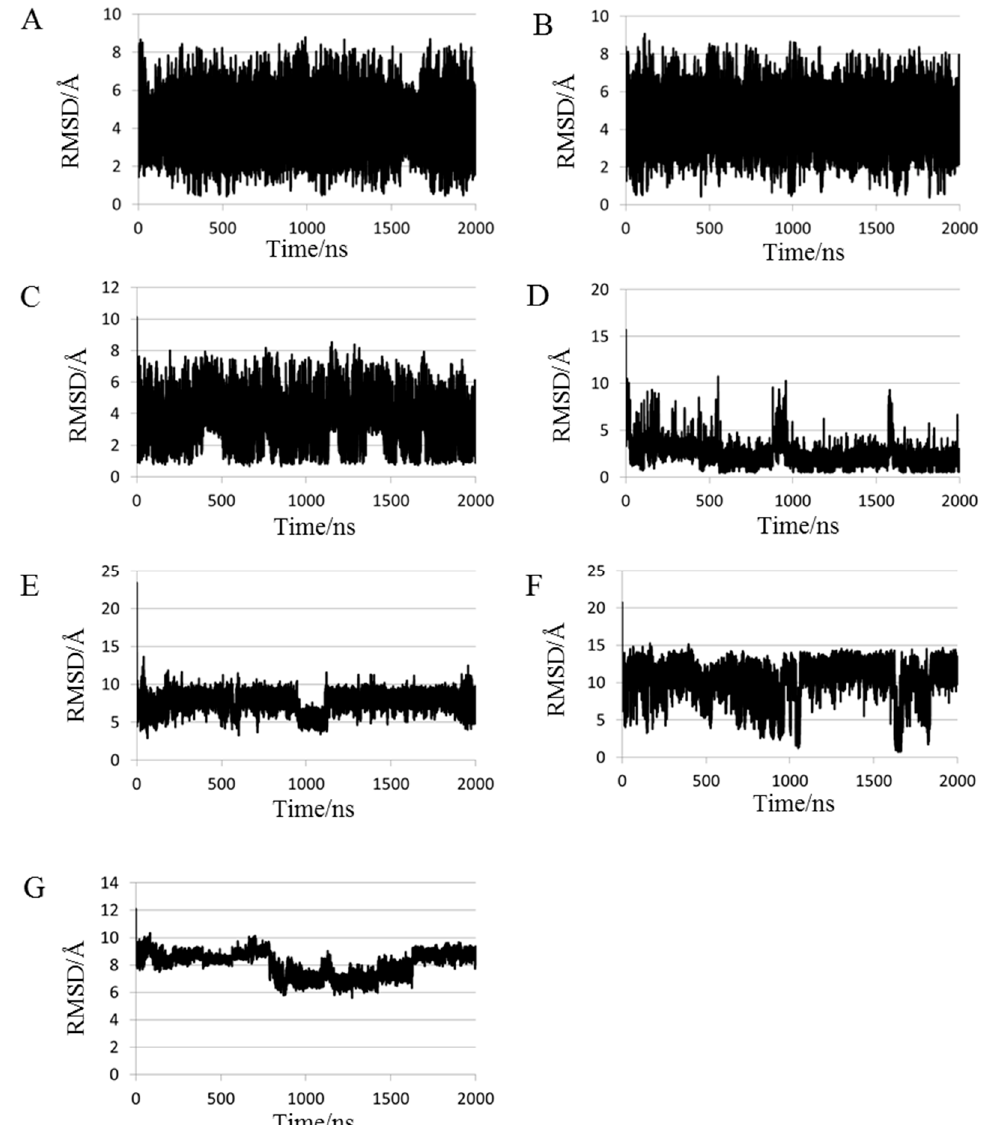
Figure 1. Root mean square deviations (RMSDs) of ( A ) chignolin; ( B ) CLN025; ( C ) 2I9M; ( D ) Trp-cage, ( E ) FSD-1; ( F ) HPH; and ( G ) crambin in normal MD simulations. The reference structures for RMSD calculations were experimental structures shown in Table 1.